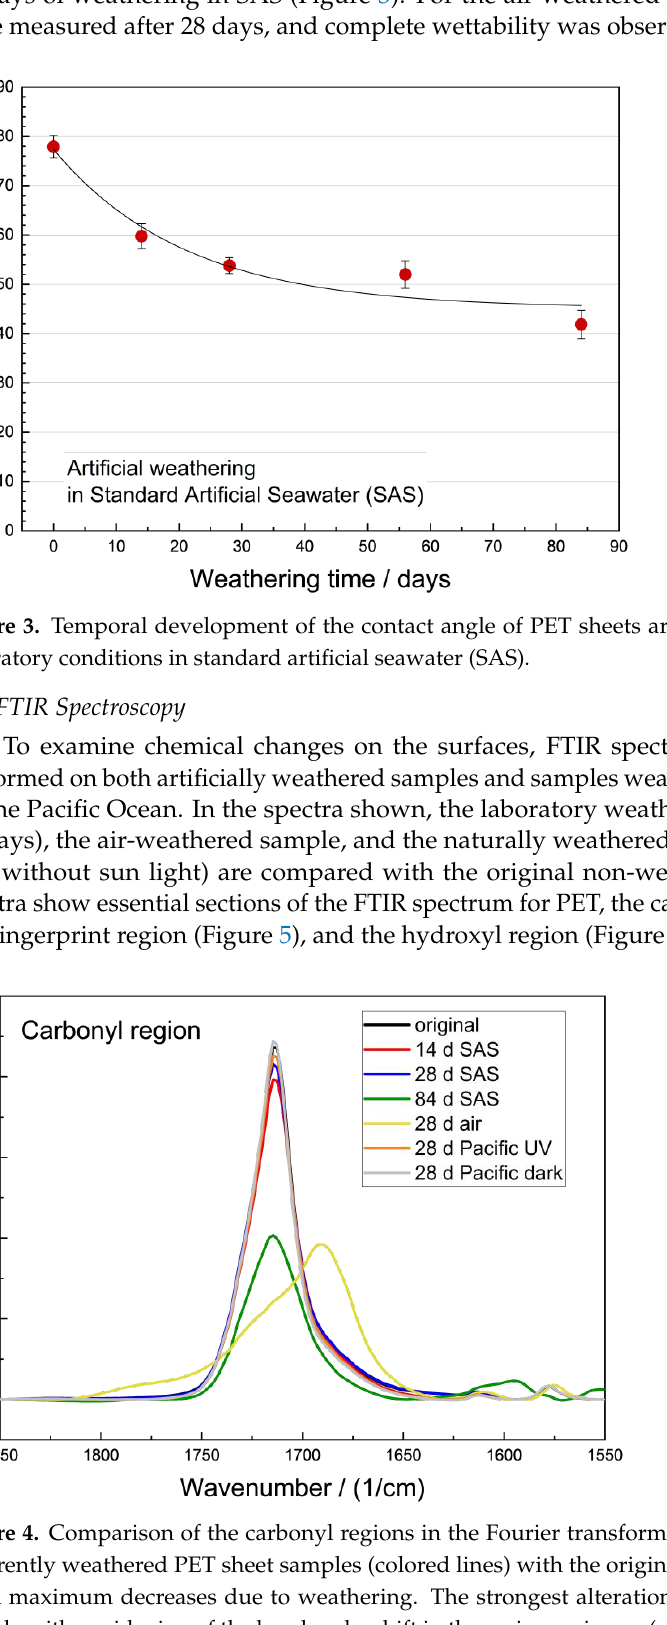
Figure 2. Temporal development of the contact angle values of polyethylene terephthalate (PET) sheets weathered under controlled natural conditions in two mesocosms either with (UV light) or without (dark) light irradiation on the Pacific Ocean. Significant decrease in contact angle values for samples taken from the mesocosm with biofilm ( A ). Small decrease in contact angle values for sam- ples with removed biofilm ( B ).